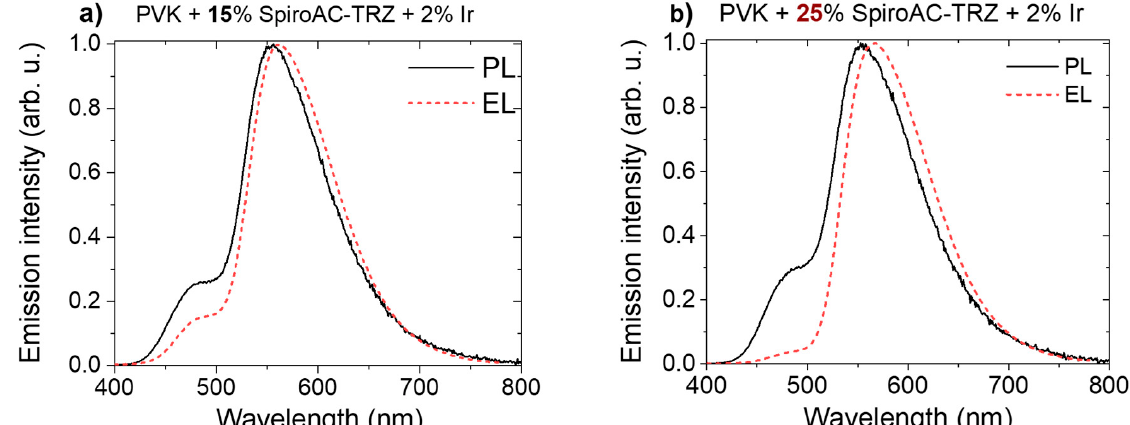
Figure 12. EL spectra (recorded at 1 mA/cm 2 ) and PL spectra of PVK + 15 or 25 wt% SpiroAC–TRZ + 2 wt% Ir.